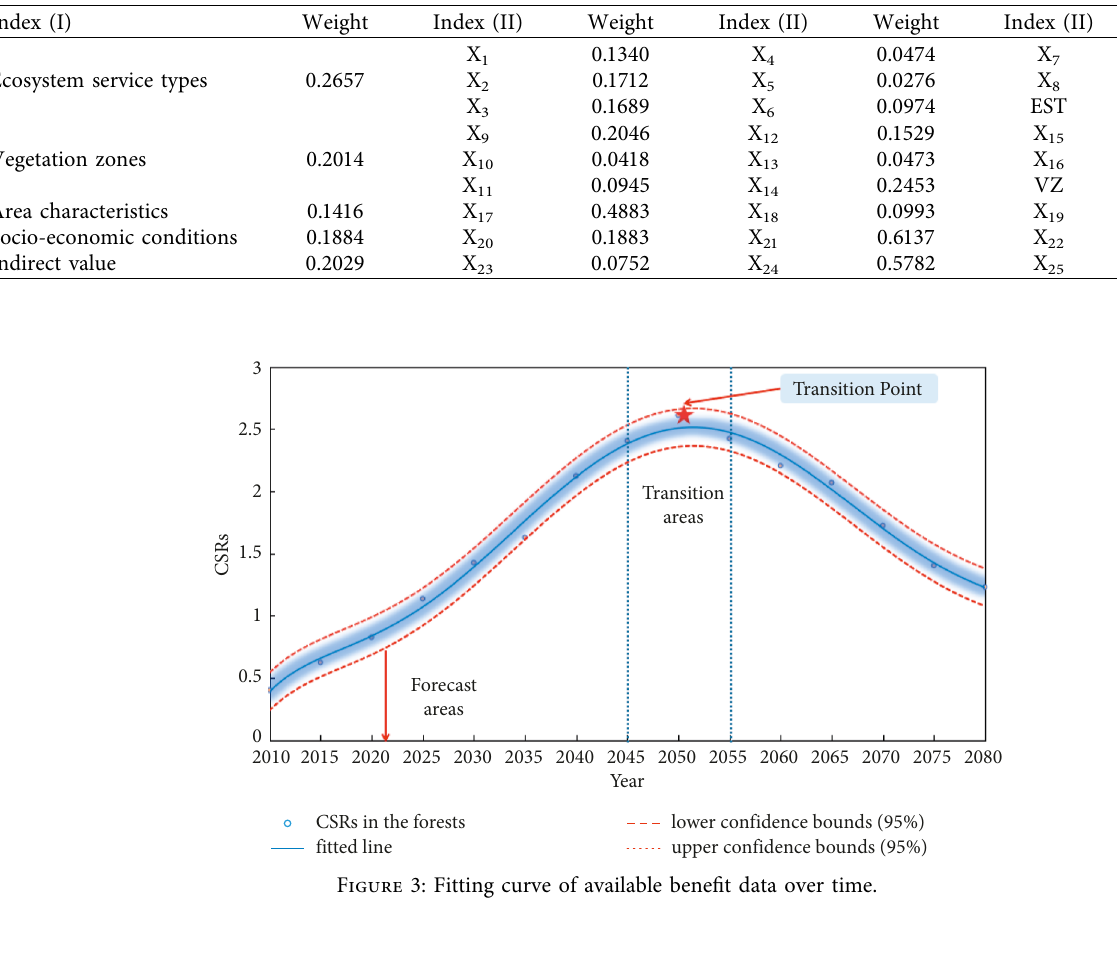
Table 2: Index weights for forest value benefits.